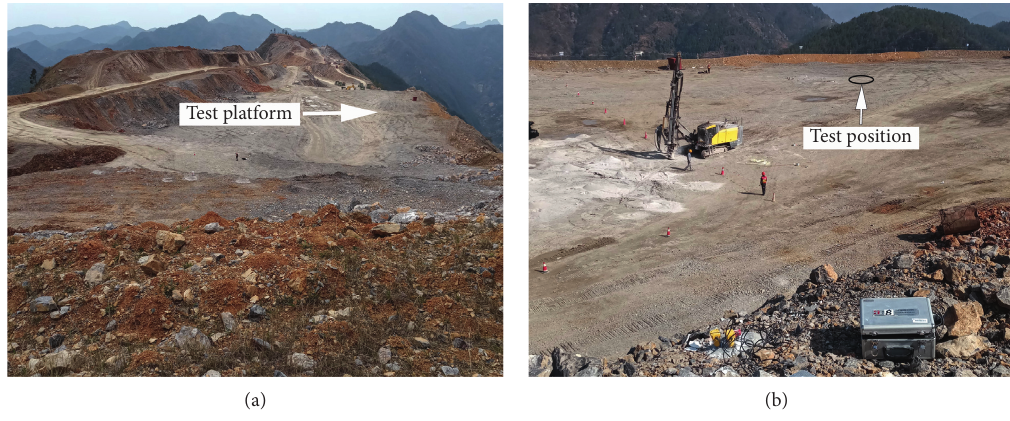
Figure 3: Mine test site: (a) test platform; (b) test position.